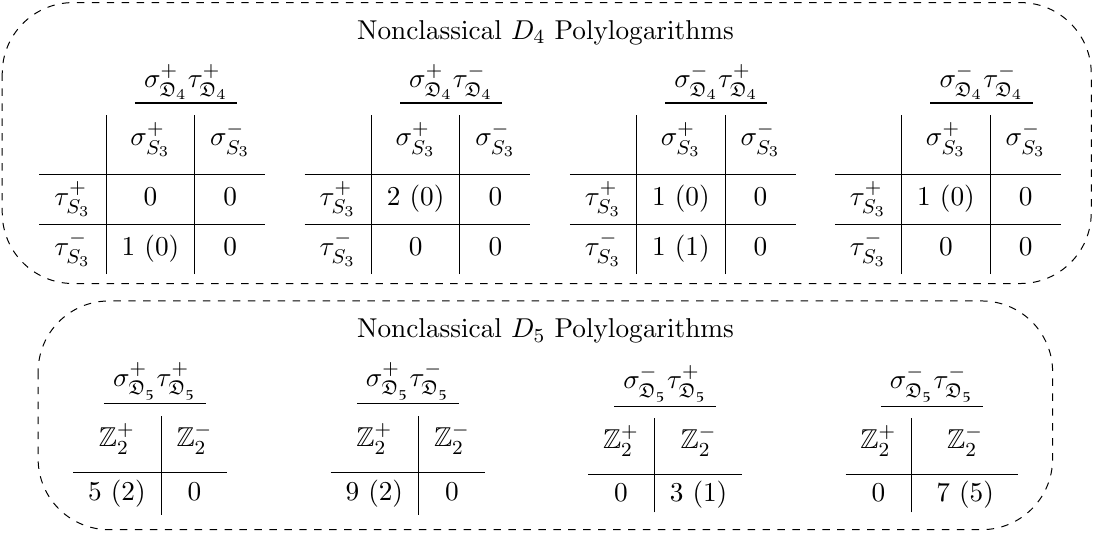
Table 2. The number of nonclassical weight-four cluster polylogarithms on the D algebras, with each possible automorphism signature. The number of functions that additionally respect cobracket-level cluster adjacency is given in